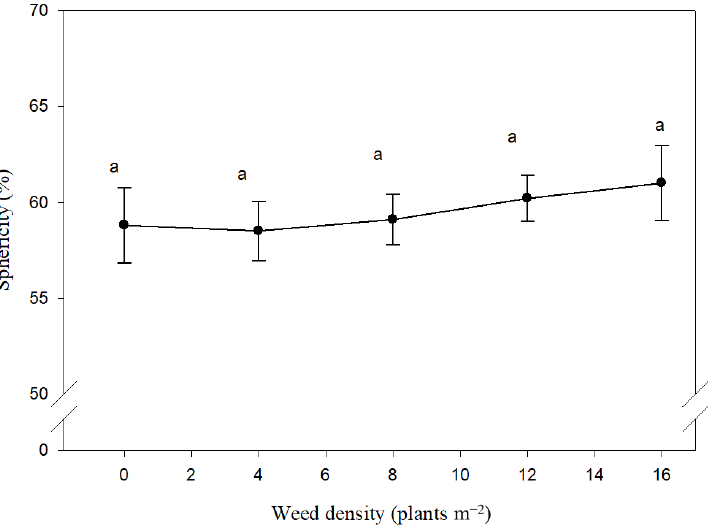
Figure 2. Effect of different density of Xanthium strumarium and Datura stramonium on maize seed sphericity. Mean values with the same letters are not significantly different based on Tukey’s studentized range test ( p ≤ 0.05). Vertical lines are standard error of mean ( n = 12; two years, two weed species and three replications).